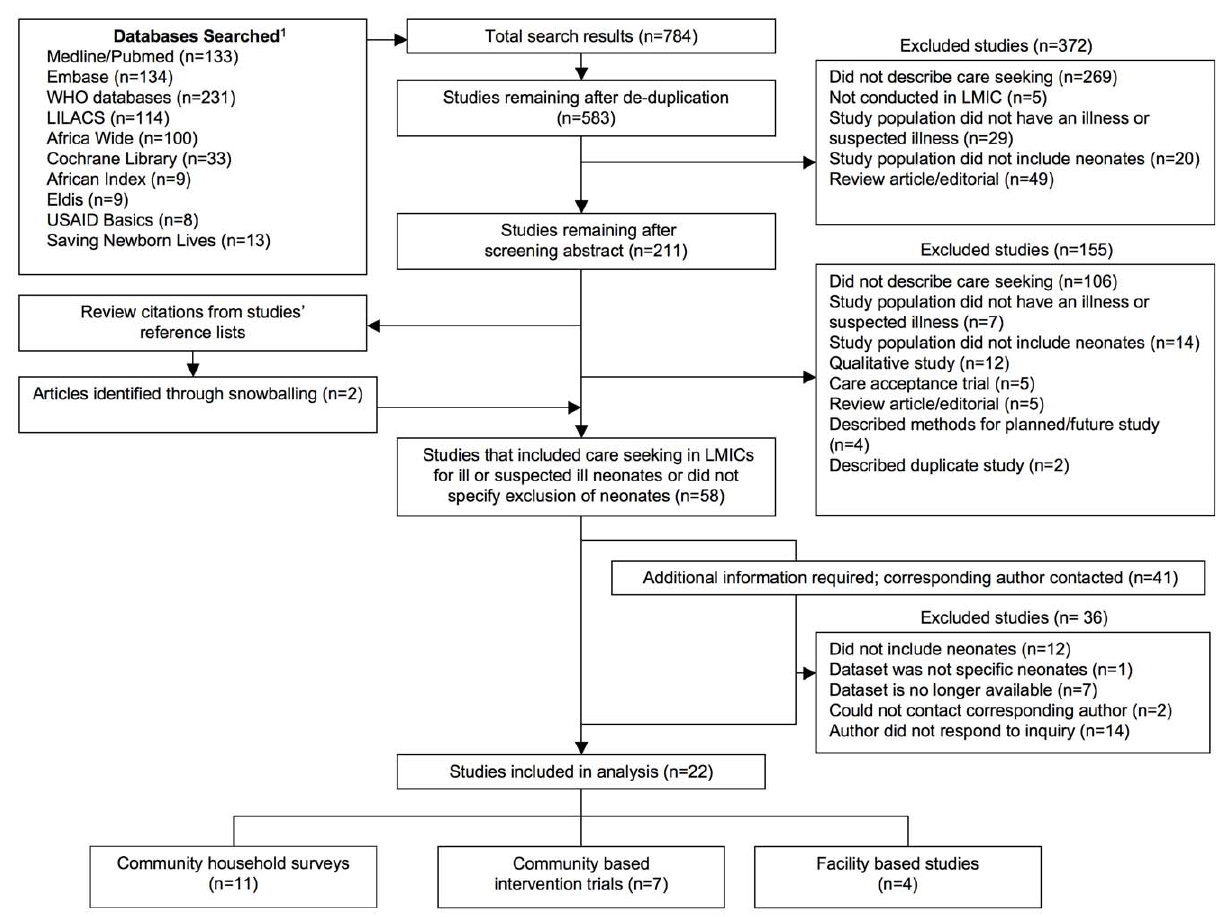
Figure 1. Literature flowchart of care seeking for ill or suspected ill neonates. Footnote 1: The following databases did not yield any search results: UNICEF, Reproductive Health Gateway, Dolphn, DHS, SPA, and African Trials.